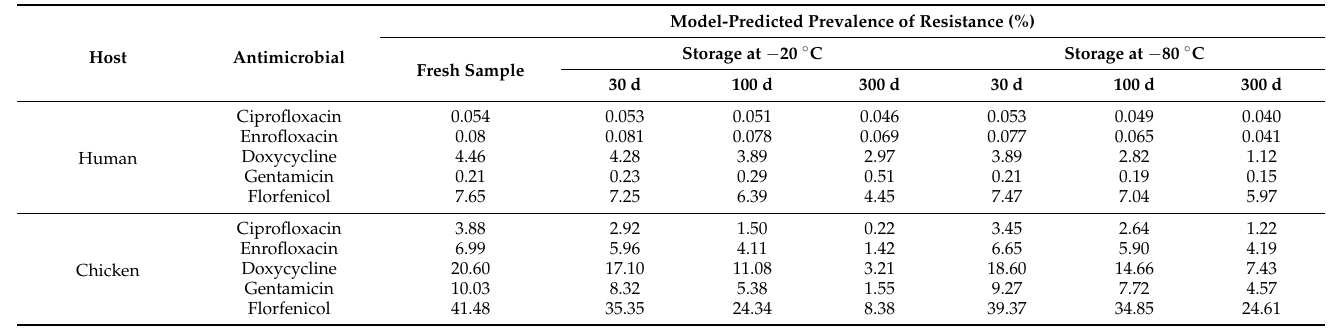
Table 2. Predictions derived from a Poisson model of the effects of storage duration and temperature on the change in prevalence (%) of phenotypic AMR in human and chicken